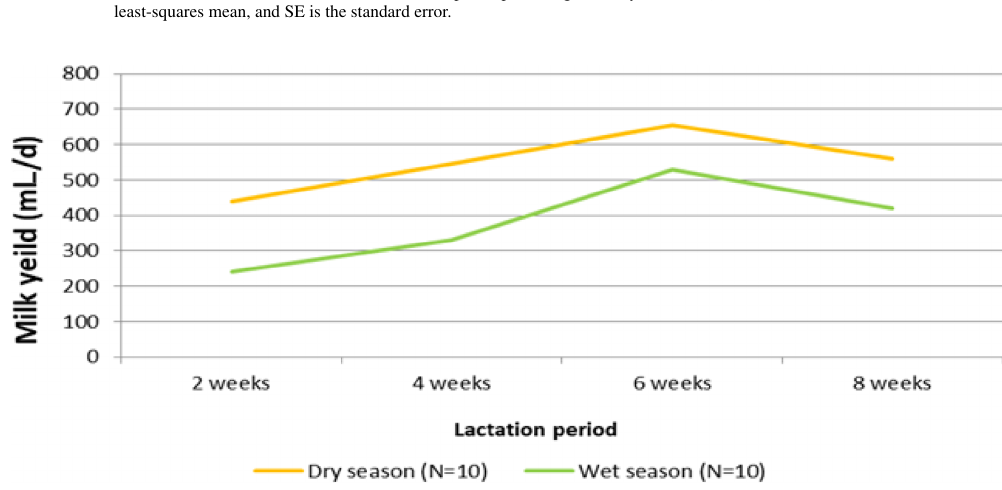
Figure 2. Effect of dry and wet seasons on milk yield of Abou-Delik